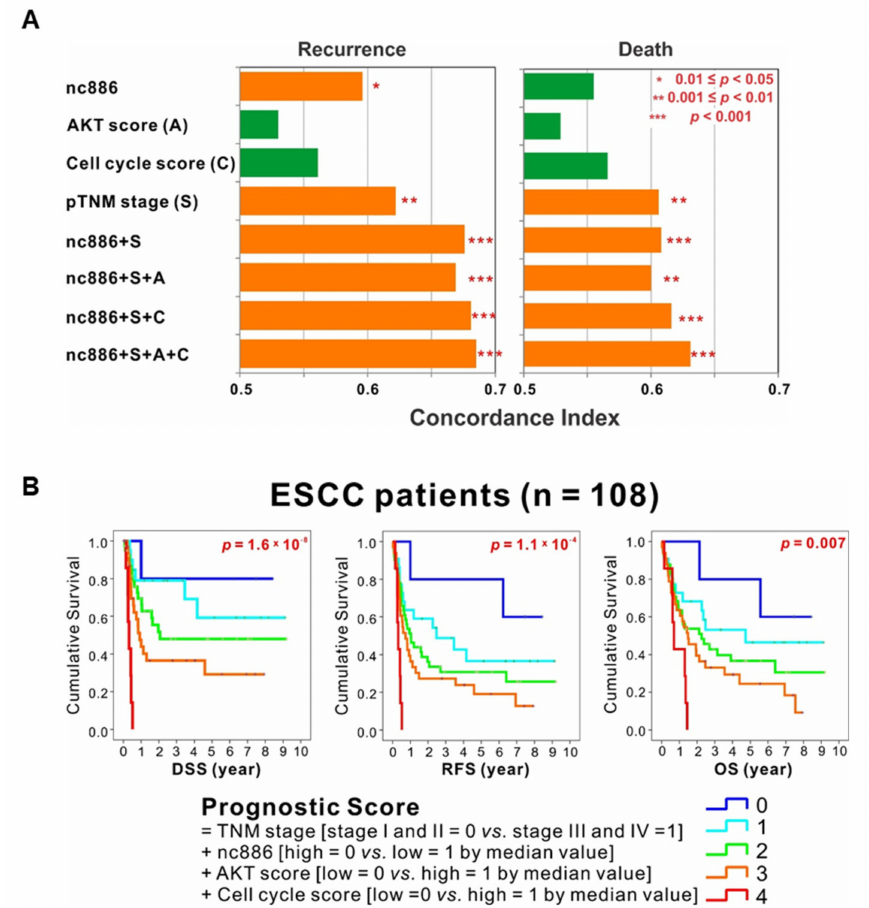
Figure 6. Prognostic value of nc886 and its associated AKT and cell cycle genes. ( A ) Concordance index showing that the combination of nc886, AKT signature score, cell cycle signature score, and tumor-node-metastasis (TNM) staging had the most powerful predictor of recurrence and survival. ( B ) Stratification by prognostic score, which is calculated as the sum of the TNM stage (score 0 for stage I and II vs. score 1 for stage III and IV), the nc886 expression (score 0 vs. 1 respectively for high vs. low expression divided by the median value), the AKT signature score (score 0 vs. 1 for low vs. high by the median value), and the cell cycle score (score 0 vs. 1 for low vs. high by the median value), showing distinct disease-specific survival (DSS), recurrence-free survival (RFS), and overall survival (OS) curves in ESCC patient